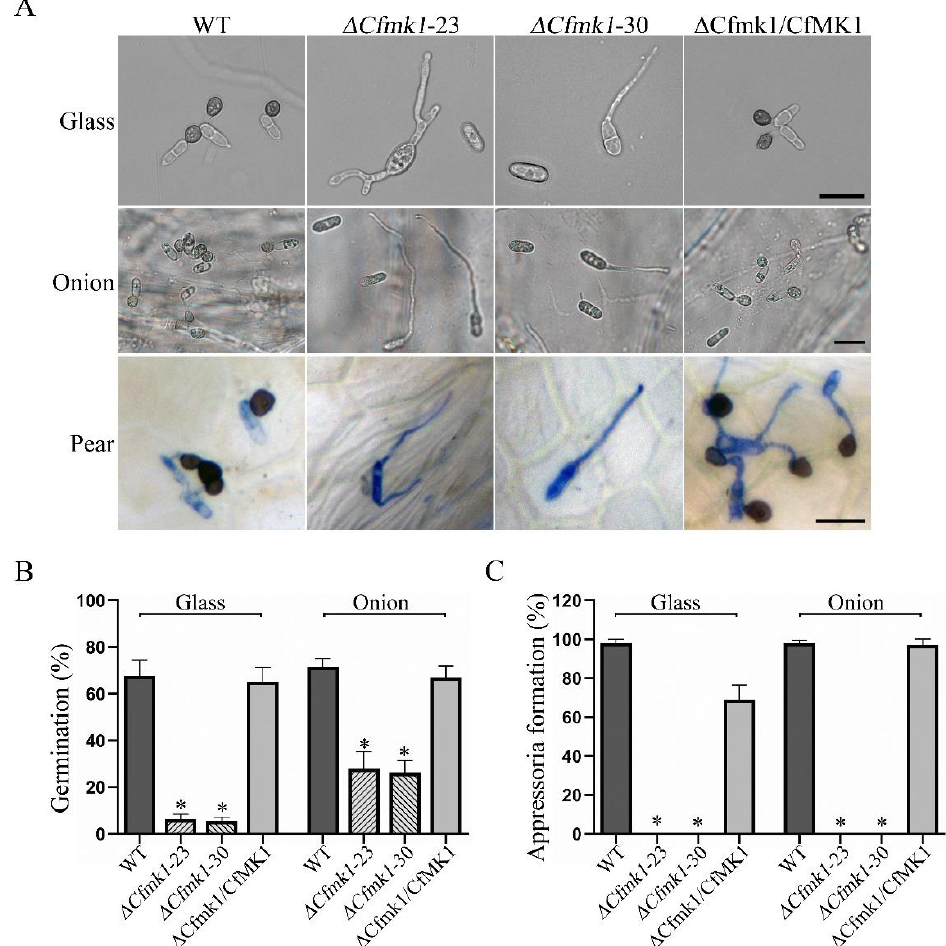
Figure 4. Germination and appressorium formation assays with the Cfmk1 deletion mutant. ( A ) Conidia of the WT, ∆ Cfmk1-23 , ∆ Cfmk1-30 , and ∆ Cfmk1 / CfMK1 were incubated on hydrophobic glass coverslips (upper panels), onion epidermal cells (middle panel), and detached pear leaves (lower panel) for 24 h. Bars = 20 μm. ( B ) Bar chart showing the conidial germination rate on hydrophobic glass slides and onion epidermal cells. ( C ) Bar chart showing the percentage of germ tubes that formed appressoria on hydrophobic glass slides and onion epidermal cells. The data were analyzed by a one-way ANOVA followed by Dunnett’s test using GraphPad Prism (version 8.0). Asterisks indicate statistically significant differences at p =